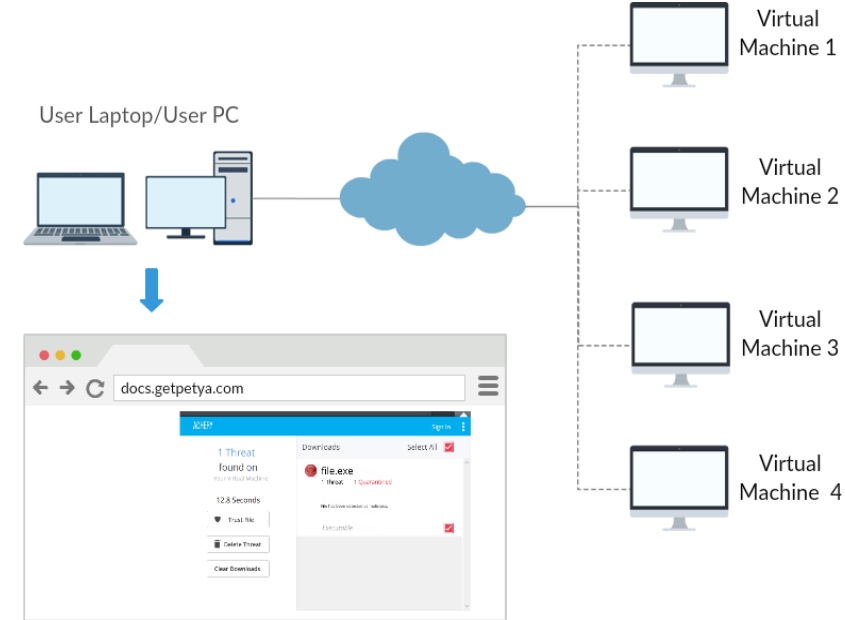
Fig. 1. Illustration of Three-Level Security